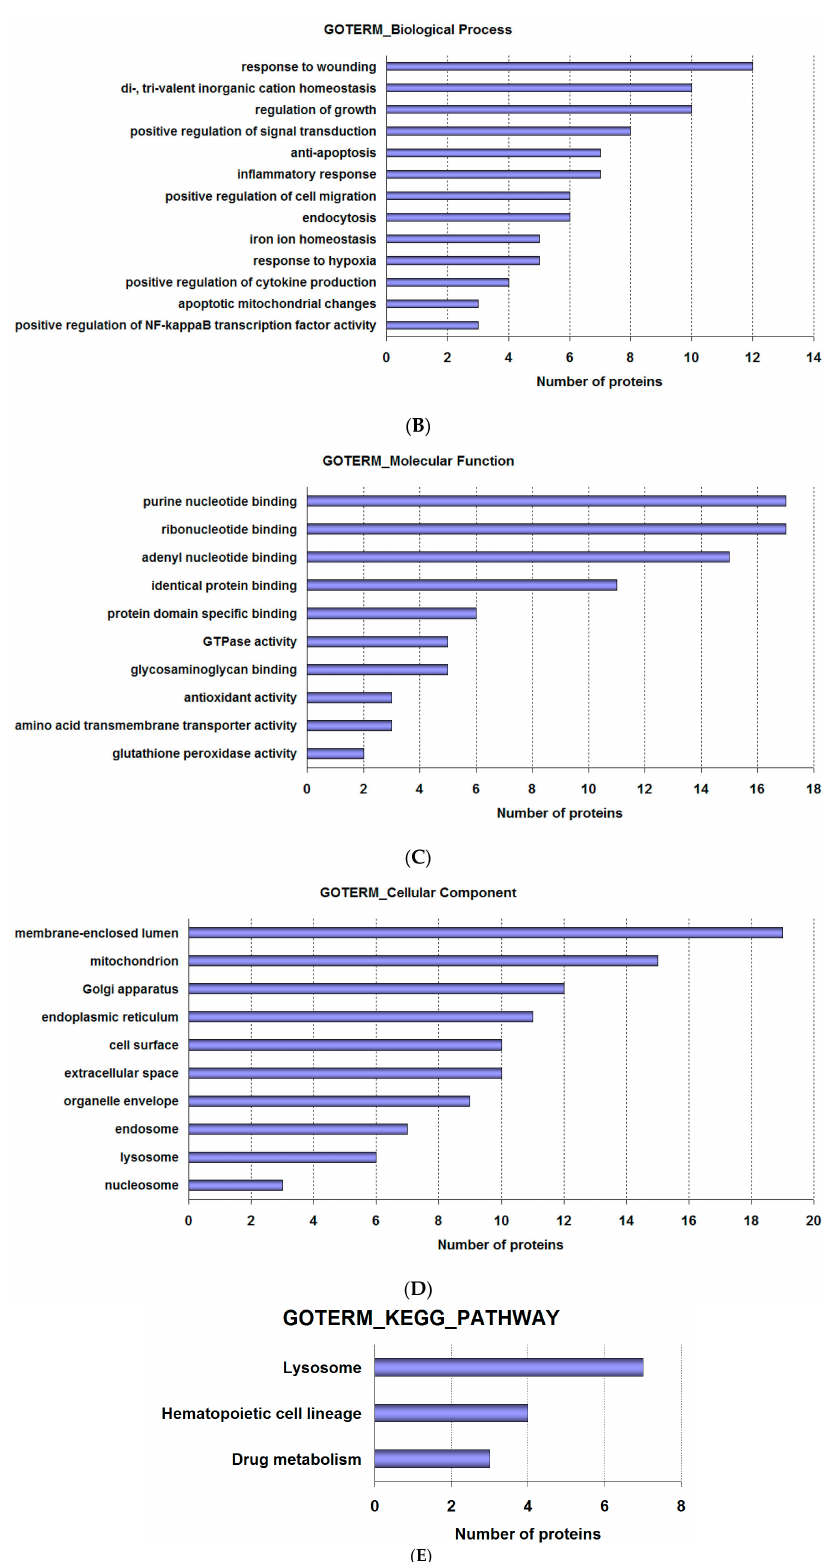
Figure 1. Differential proteomic analysis in HH4 cells. ( A ) Volcano plot of 2502 differentially expressed proteins between iron overload treatment group and control group in HH4 cells. ( B – D ) Functional classification of differentially expressed proteins using SWISS-PROT database based on universal GO annotation terms. Proteins shown were linked to at least one annotation term within the GO biological process ( B ); molecular function ( C ); and cellular component ( D ) categories; ( E ) KEGG pathway analysis. Table 1. Proteins differentially expressed in response to iron overload in HH4 cells.